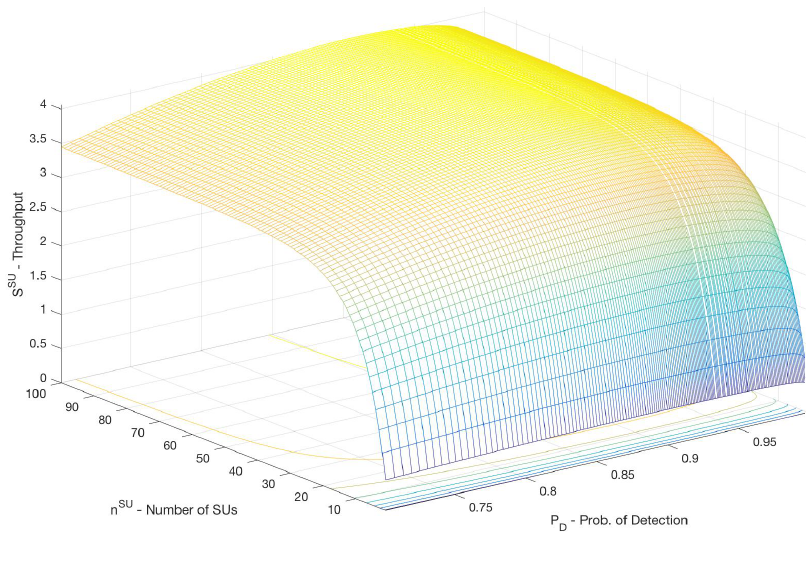
Figure 7. Conditional throughput ( S SU ) achieved by SU versus P D and n SU , for α = 3 and σ ξ =